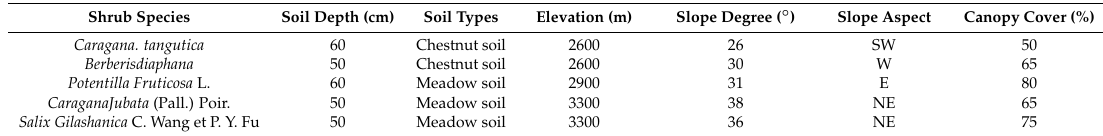
Figure 1. Study area with sample plots (numbers 1–5) and main shrub species. ( 1 ) Caragana tangutica ; ( 2 ) Berberis diaphana; ( 3 ) Potentilla Fruticusa L. ; ( 4 ) Salix Gilashanica C. Wang et P. Y. Fu; and ( 5 ) Caragana Jubata (Pall.) Poir. Table 1. Sample plot information.